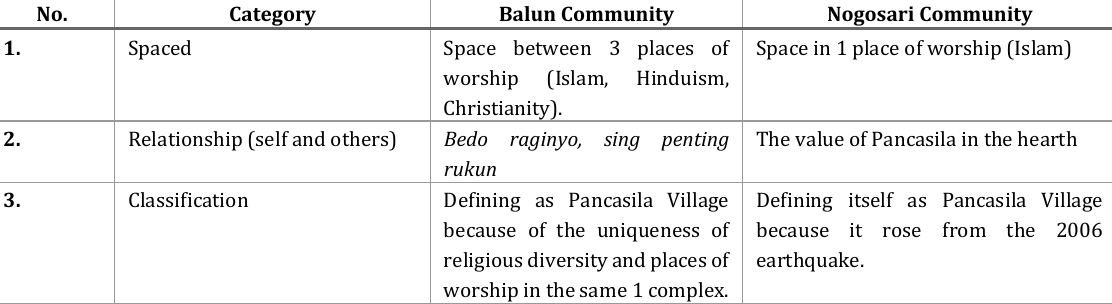
Table 1. The Comparison between Two